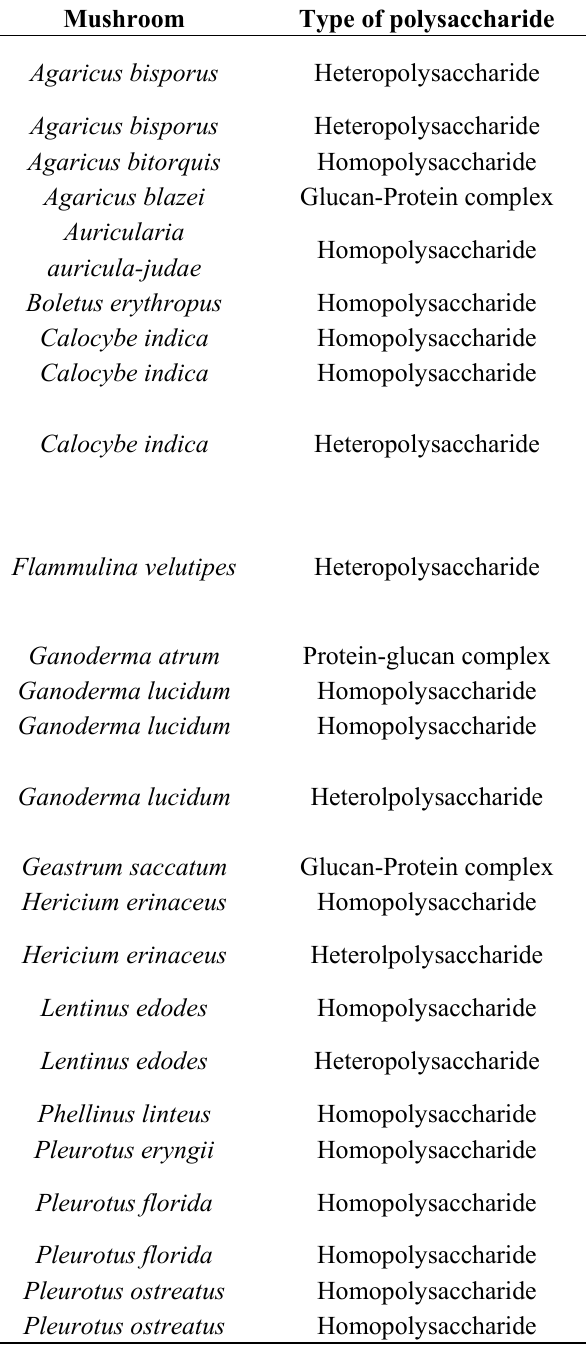
Table 1 reviews the main important structural features of polysaccharides isolated from mushrooms. Table 1. Structural features of polysaccharides isolated from